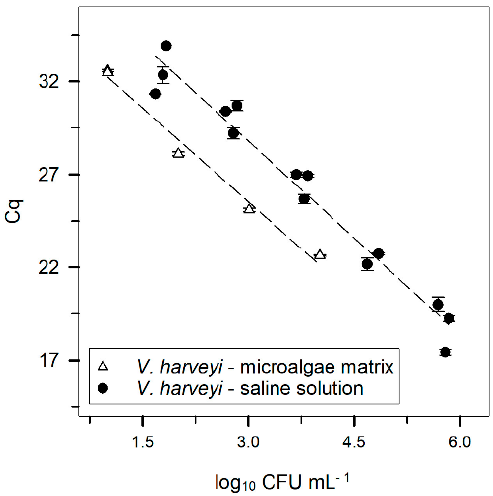
Figure 3. Correlation between the logarithm of V. harveyi (CFU mL − 1 ) concentration in different matrixes—